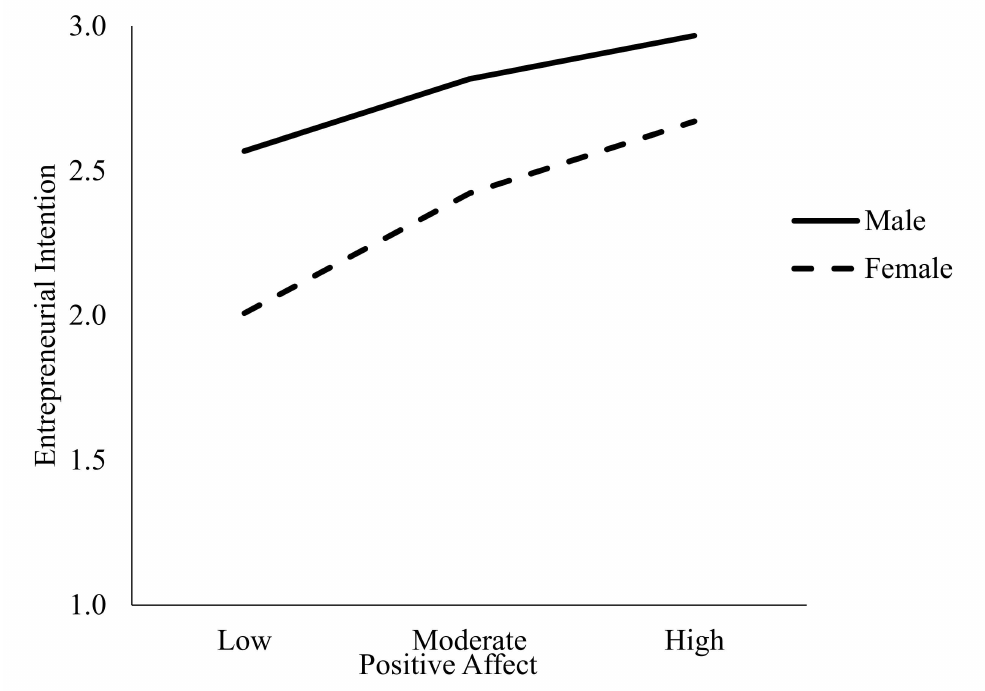
Figure 2. Interaction of positive a ff ect and gender on entrepreneurial